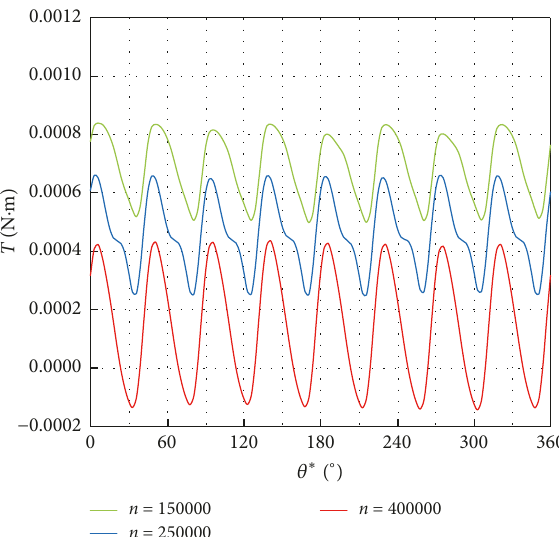
Figure 14: Torque fluctuation during one rotation of